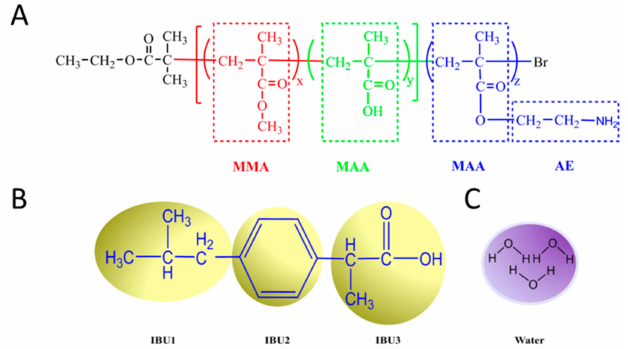
Figure 1. Coarse-grained models of ( A ) block copolymer poly(MMA- co -MAA)- b -PAEMA, ( B ) ibuprofen, ( C ) water.